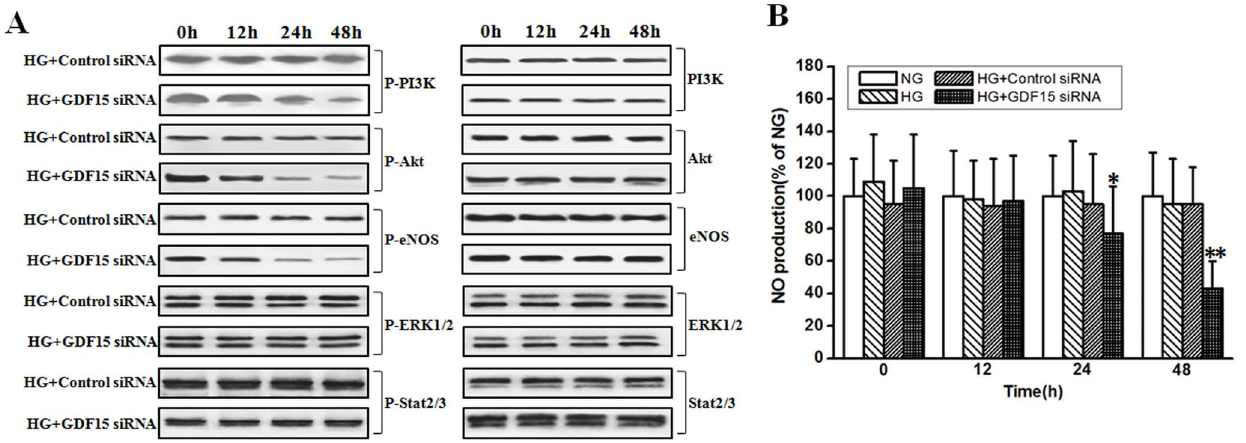
Figure 5. Inhibition of adaptively induced GDF15 expression attenuated PI3K/Akt/eNOS pathway. GDF15 siRNA or negative control siRNA were transfected into HUVEC cells. 12 h after transfection, HUVEC cells were treated with high (33.3 mmol/l) glucose. A, at indicated time points, phosphorylation and total amount of PI3K, Akt, eNOS, ERK1/2, and Stat2/3 were detected by western blot. B, The concentrations of NO in the culture medium were measured using the nitric oxide colorimetric assay kit as described in the materials and methods. NG, normal glucose. HG, high glucose. *, P , 0.05, **, P , 0.01 versus HG.